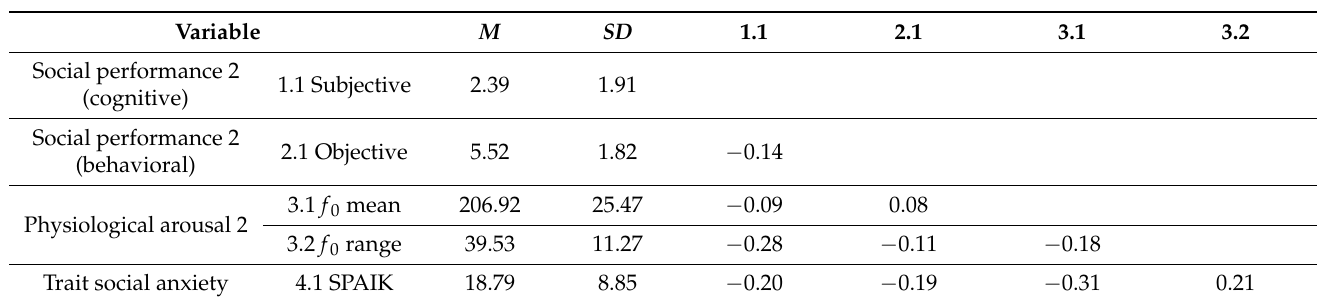
Table 4. Means, Standard Deviation and Pearson Correlations for Variables After CBT or Waiting ( n =